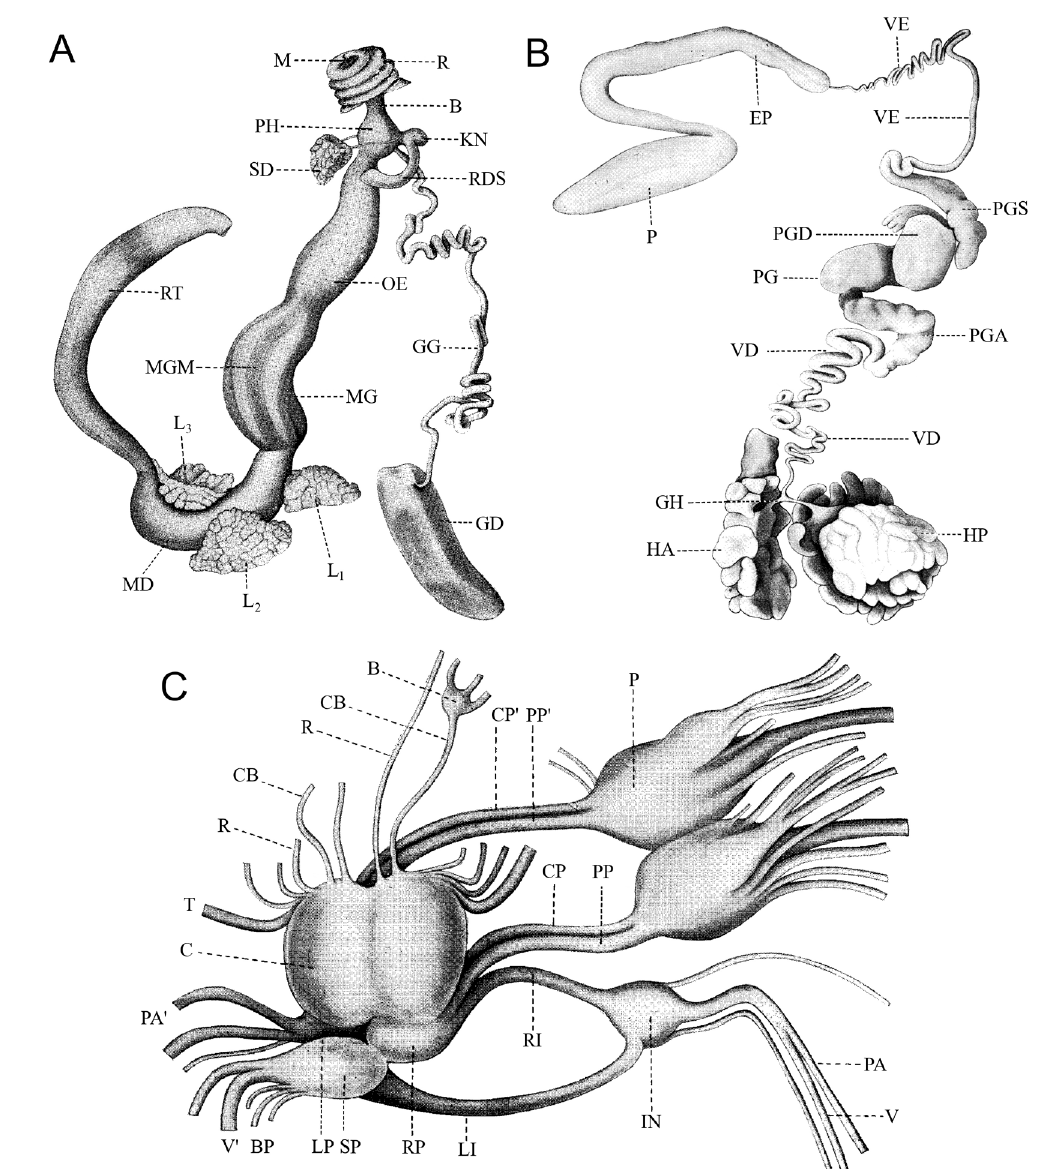
Fig. 4. Profundiconus tuberculosus (Tomlin, 1937) (reproduced from Taki 1937, with permission from the Zoological Society of Japan). A . Digestive apparatus: A = anus; B = bucal mass; GD = venom bulb; GG = venom duct; KN = caecum of radular sac; L , L , L = liver; MD = middle gut; MGM = stomach 1 2 3 muscle; PH = pharynx; R = circular muscles of proboscis; RDS = radular sac; RT = rectum; SD = salivary gland. B . Male reproductive apparatus: EP = epiphalus; HA = anterior lobe of testis; HP = posterior lobe of testis; GH = excretory duct of testis; P = penis; PG = prostate; PGA = anterior part of prostate; PGD = posterior part of prostate; PGS = final part of prostate; VD = vas deferens, anterior part; 1 VD = vas defferens, thickened part; VE = vas efferens, posterior part; VE = vas efferens, anterior part. 2 1 2 C . Nervous system: C = cerebral ganglion; CB = cerebral-buccal connective; CP = right cerebropedal connective; CP’ = left cerebropedal connective; IN = subintestinal ganglion; LI = left pleuro sub- intestinal connective; LP = left pleural ganglion; P = peda-ganglion; PA = right parietal nerve: PA’ = left parietal nerve; PP = right pleuropedal connective; PP’ = left pleuropedal connective; SP = supra-intestinal ganglion; T = tentacular nerve; V = right visceral connective; V’ = left visceral